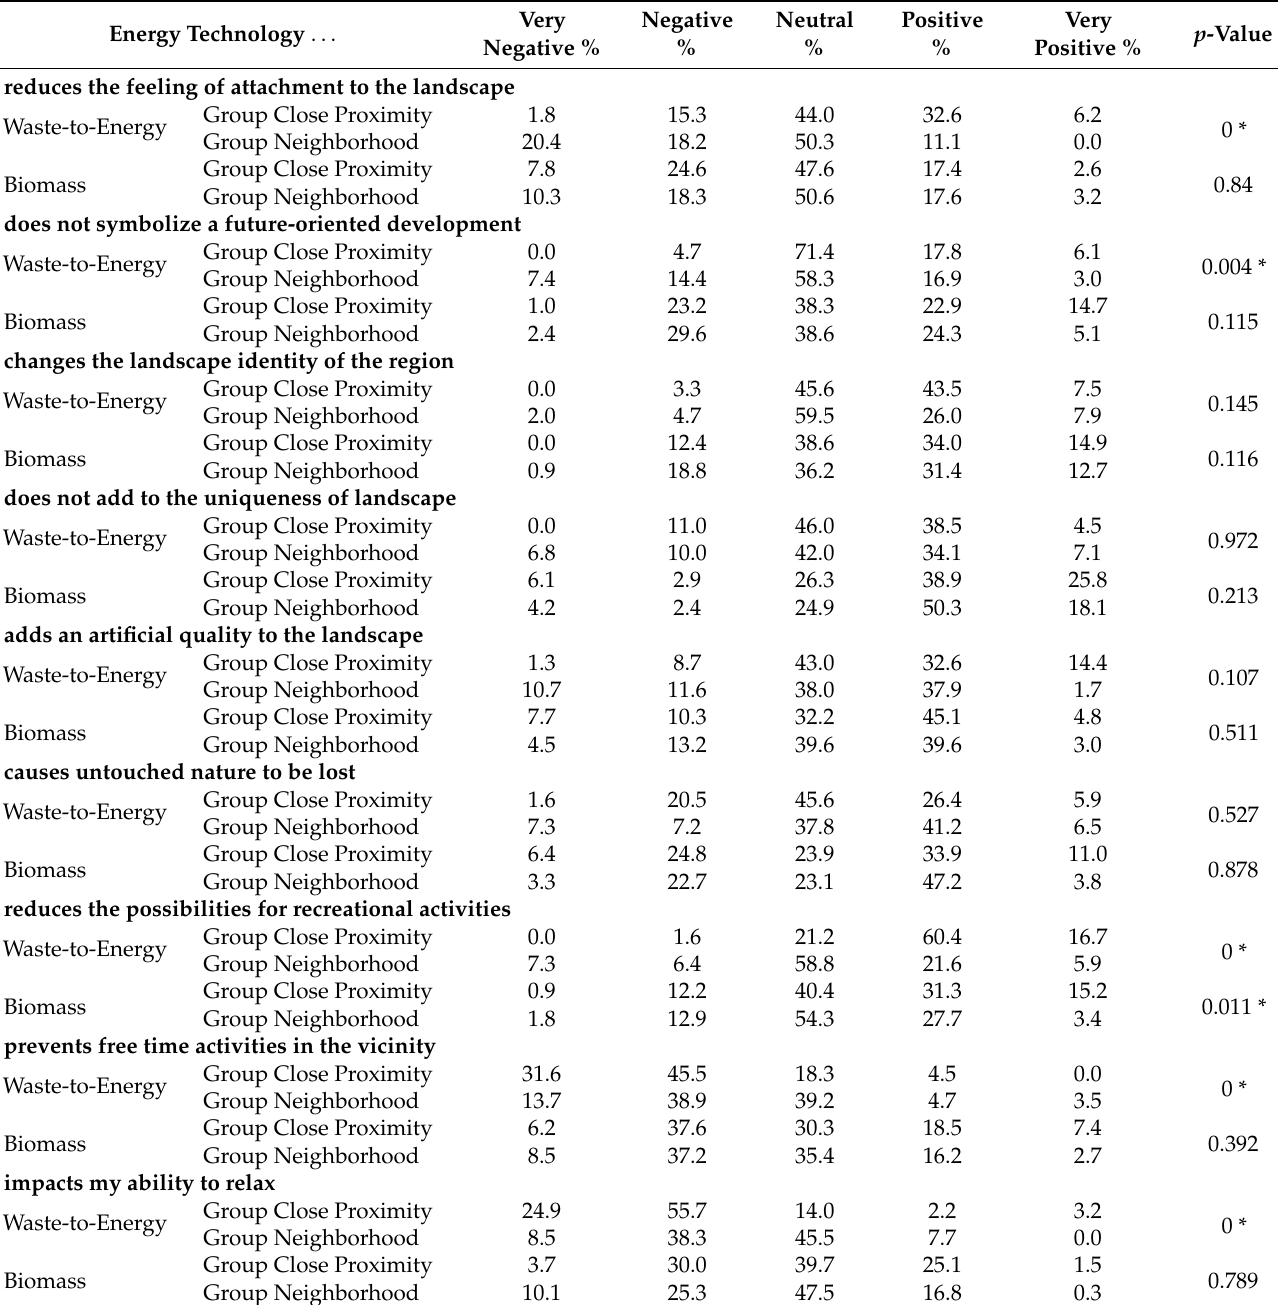
Table A3. Evaluation of experienced impact on landscape quality in the waste-to-energy and biomass groups—differentiation between people living close (Group Close Proximity) and the ones living further away (Group Neighborhood). Energy Technology . .